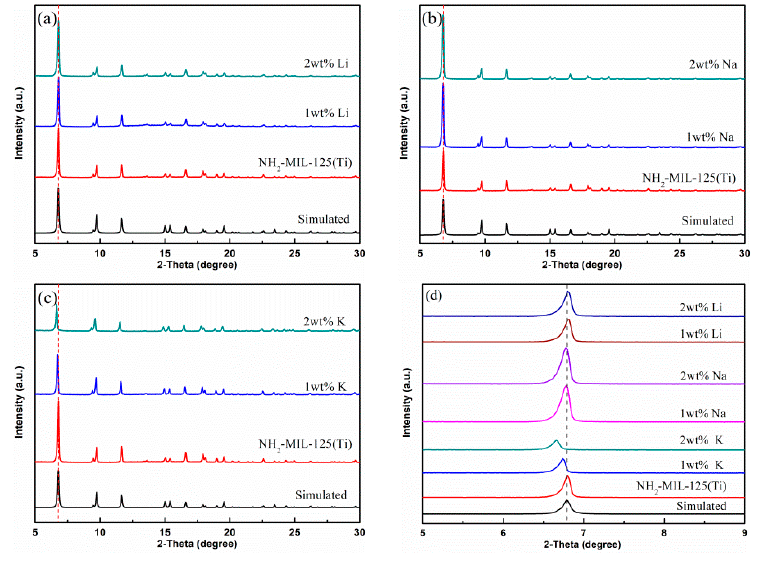
Figure 2. XRD patterns of doped NH 2 –MIL125(Ti): ( a ) x Li@NH 2 –MIL125(Ti), ( b ) x Na@NH 2 –MIL125(Ti), ( c ) x K@NH 2 –MIL125(Ti), and ( d ) magnification part for x M@NH 2 –MIL125(Ti).